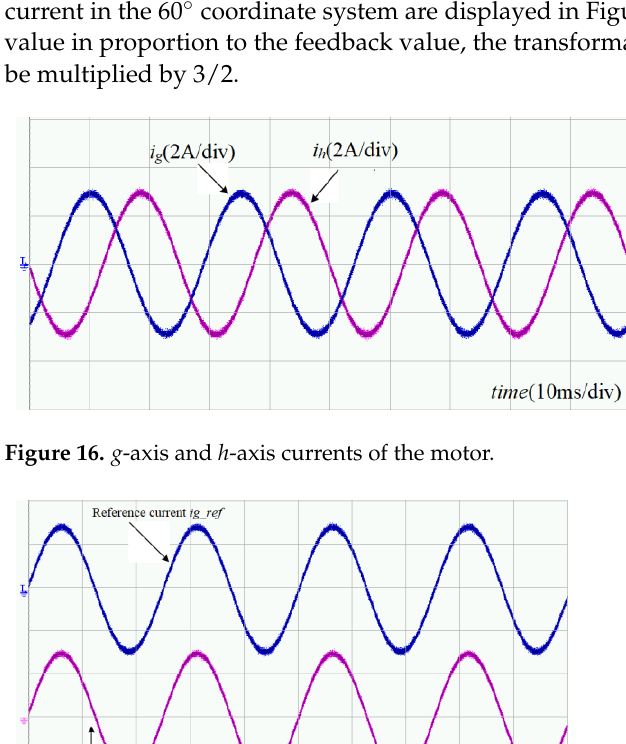
Figure 18. Three-phase currents of the motor. Figure 19. Speed and torque responses of the motor.